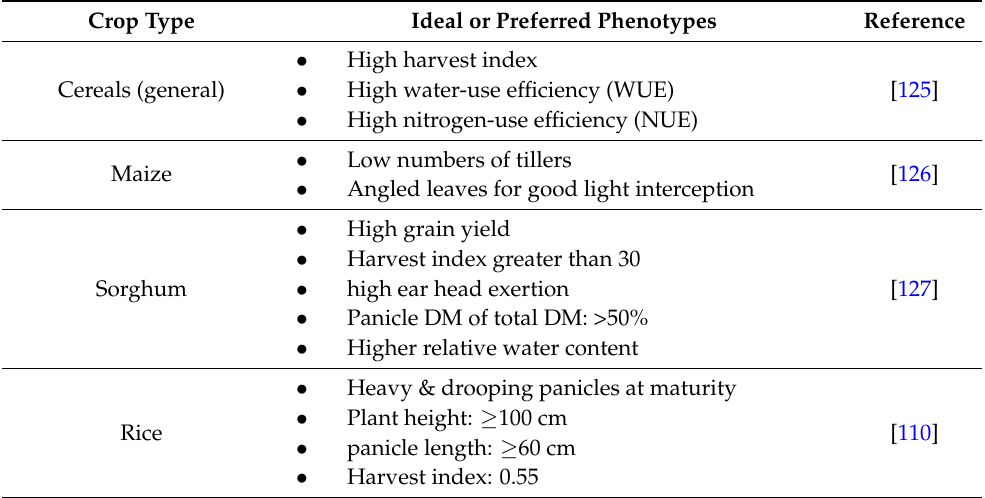
Table 2. Key features of ideotypes of selected